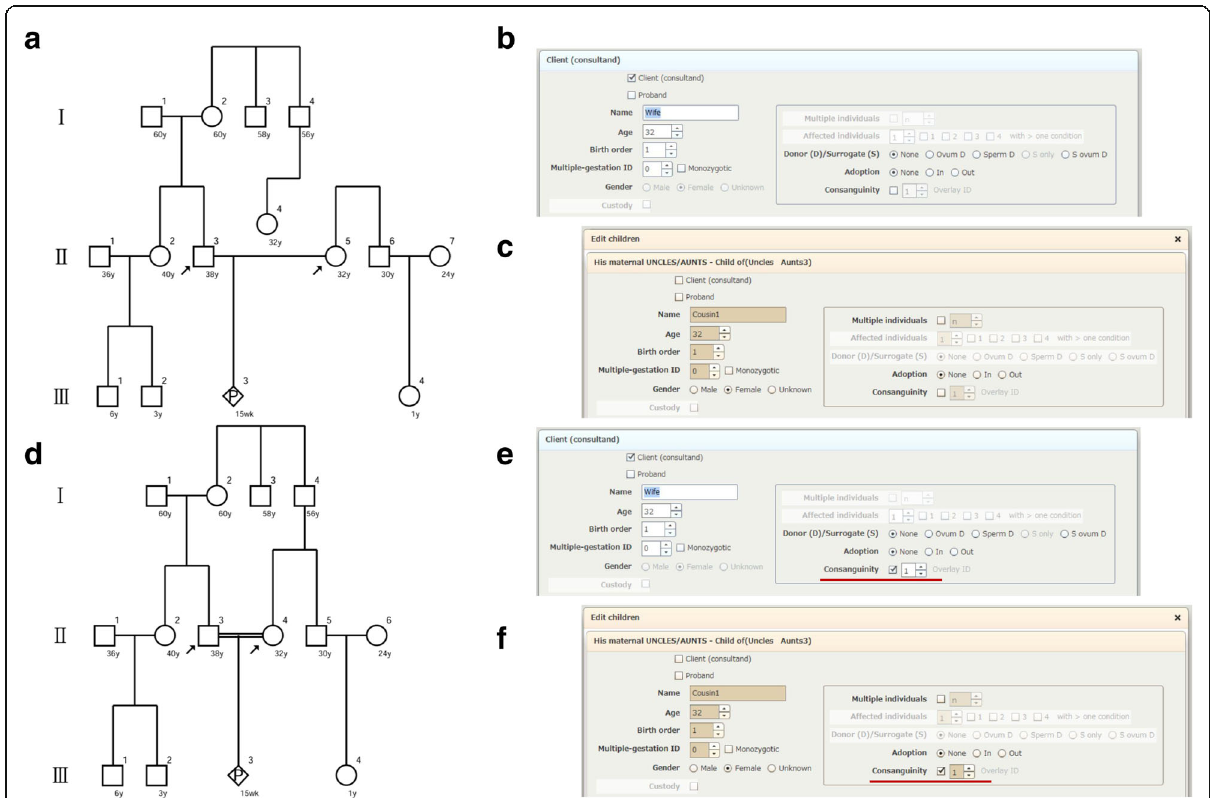
Fig. 4 Overlay function of f-treeGC for consanguinity; a pedigree before ( a ) and after ( d ) overlay; the interview sheets of the wife ( b , e ) and a first cousin ( c , f